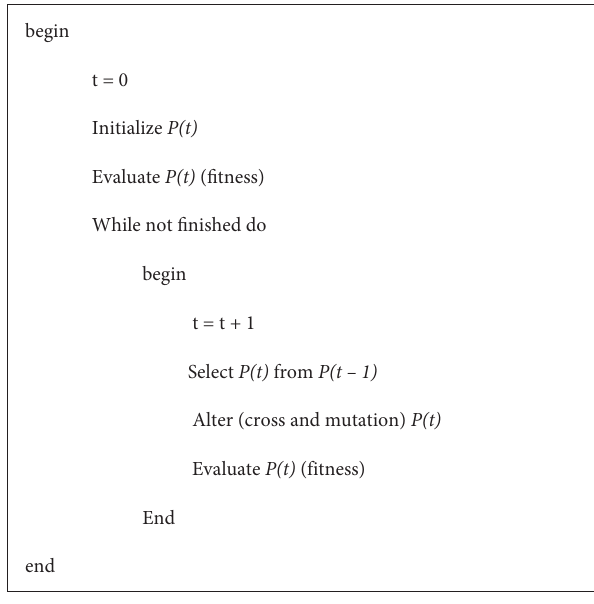
Figure 6: A simple genetic algorithm.